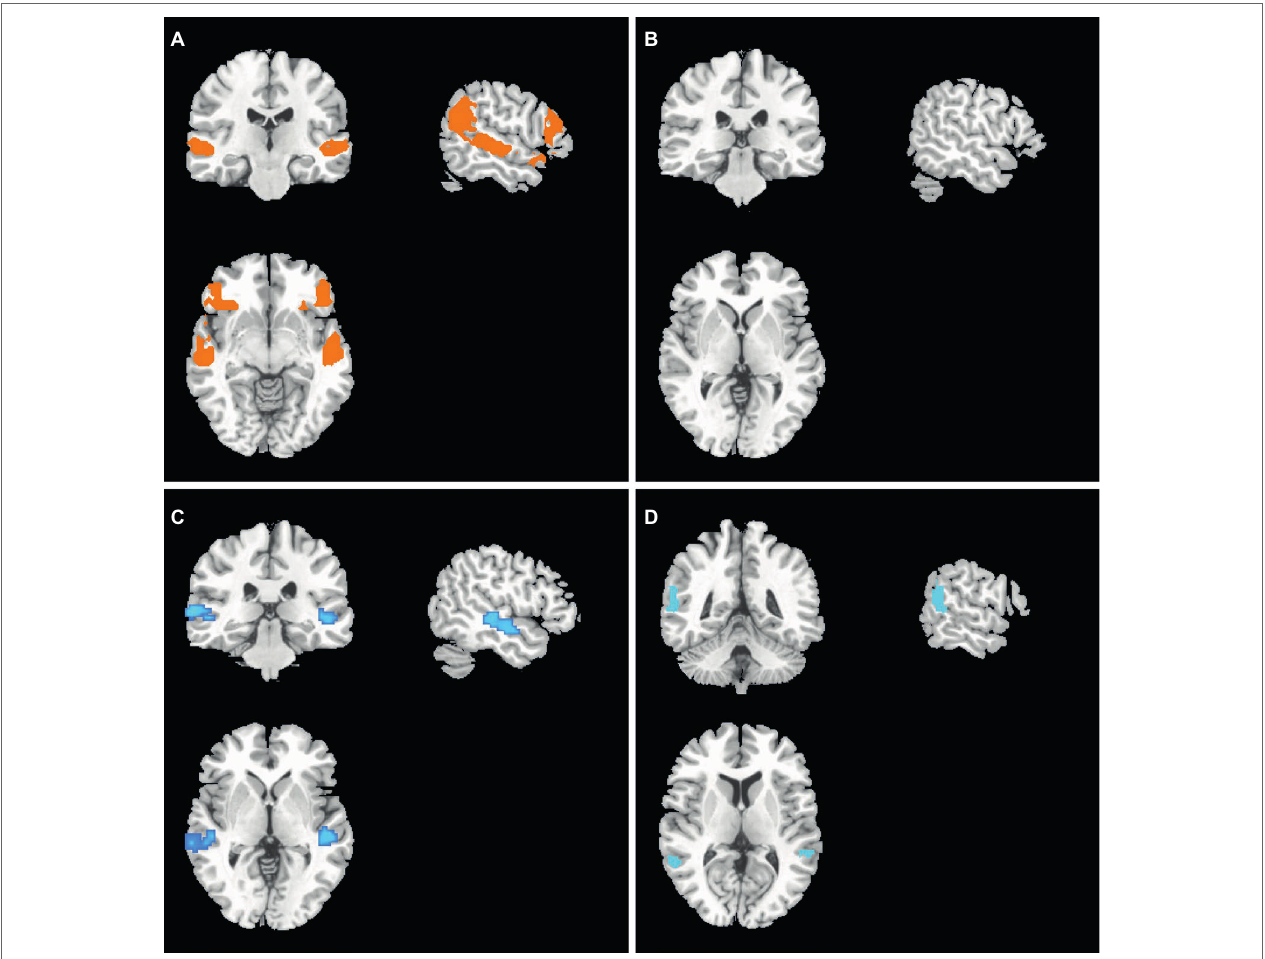
FIGURE 2 | gFCD and GMV differences between two